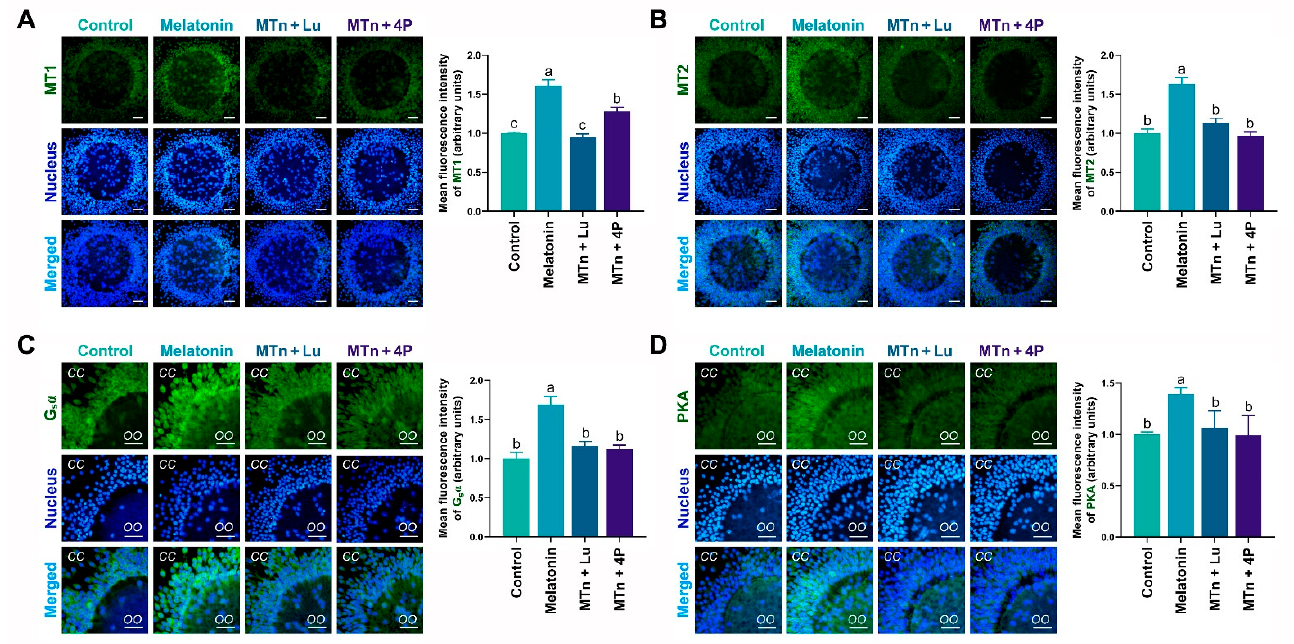
Figure 2. Immunofluorescence analysis of melatonin receptors ( A , B ), G s α ( C ) and PKA ( D ) proteins in cumulus cells. Melatonin/MTn, 10 − 9 mol/L melatonin; Luzindole/Lu, 10 − 9 mol/L Luzindole; 4P-PDOT/4P, 10 − 9 mol/L 4P-PDOT. Scale bar = 30 µ m. Different letters denote significant difference ( p <